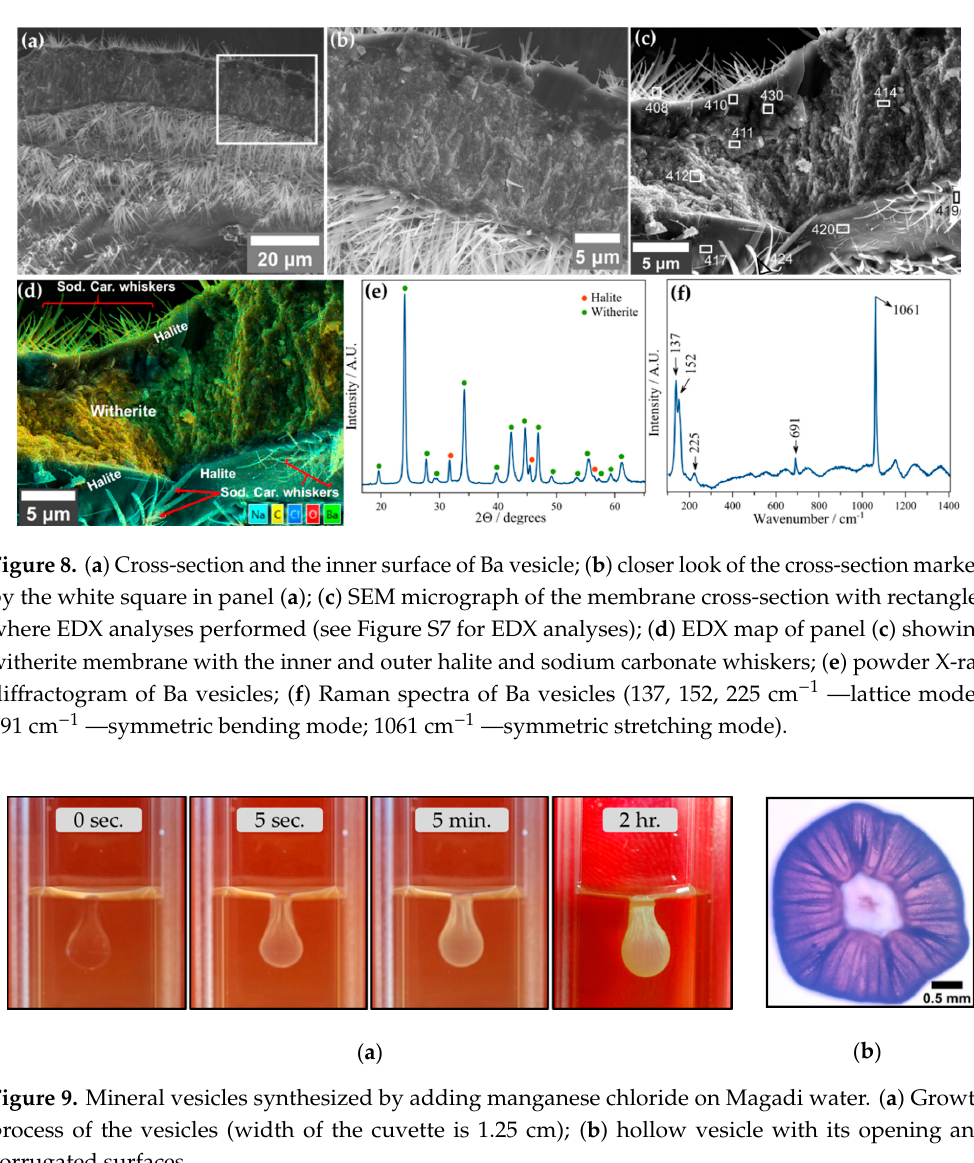
Figure 8. ( a ) Cross-section and the inner surface of Ba vesicle; ( b ) closer look of the cross-section marked by the white square in panel ( a ); ( c ) SEM micrograph of the membrane cross-section with rectangles where EDX analyses performed (see Figure S7 for EDX analyses); ( d ) EDX map of panel ( c ) showing witherite membrane with the inner and outer halite and sodium carbonate whiskers; ( e ) powder X-ray diffractogram of Ba vesicles; ( f ) Raman spectra of Ba vesicles (137, 152, 225 cm − 1 — lattice modes; 691 cm − 1 —symmetric bending mode; 1061 cm − 1 —symmetric stretching mode).